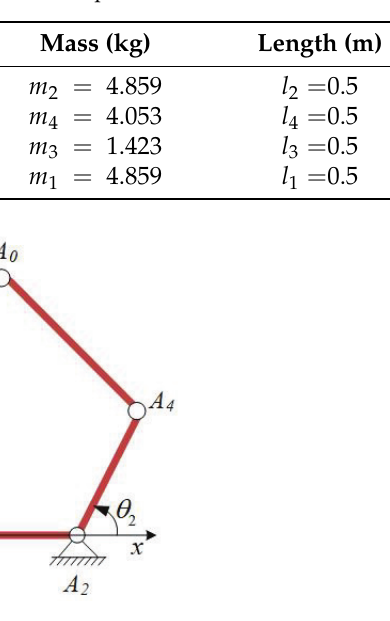
Table 1. Parameters of the parallel robot.